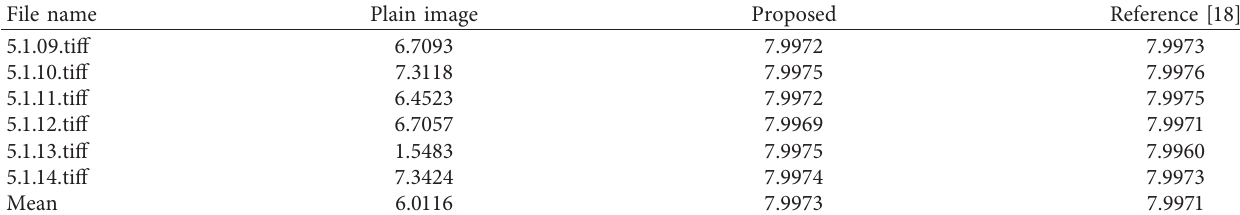
Table 3: Information entropy